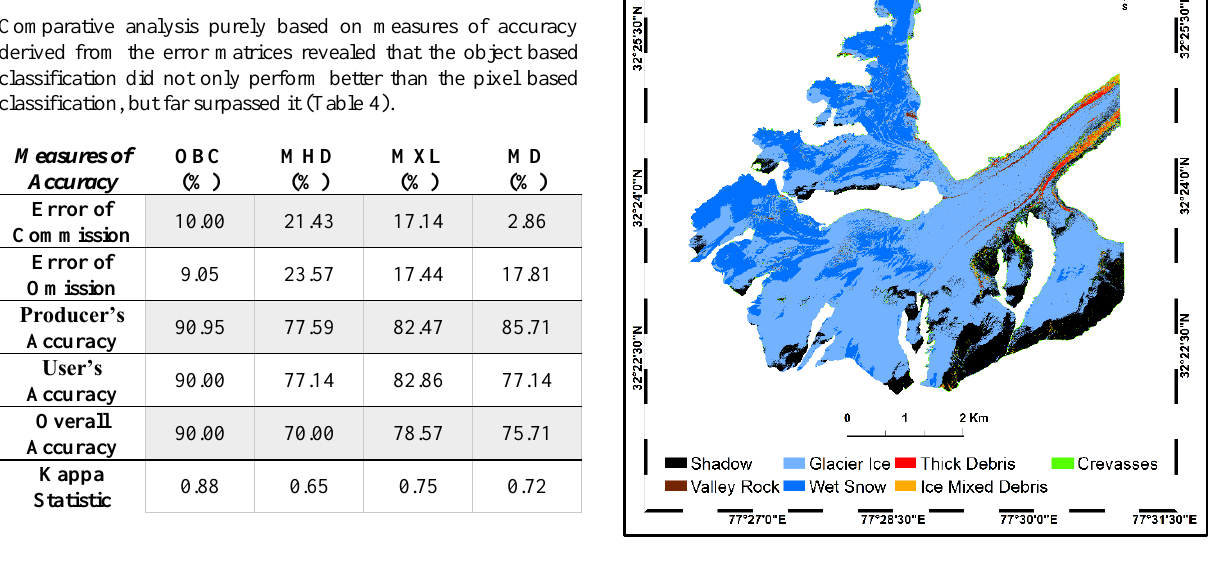
Figure 3. Mahalanobis distance classification